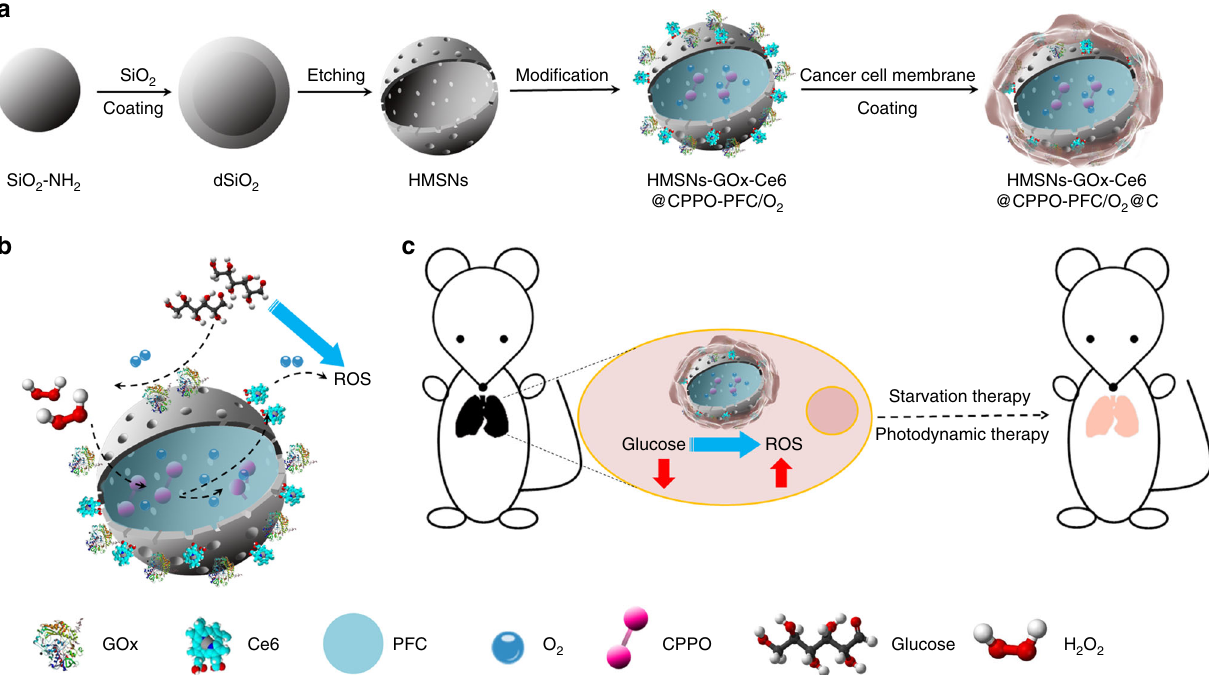
Fig. 1 Schematic illustrations of the process for synthesizing the biomimetic nanoreactor ( a ), ROS generation based on CRET with glucose consumption with no light excitation ( b ), and synergetic photodynamic-starvation therapy for metastases ( c